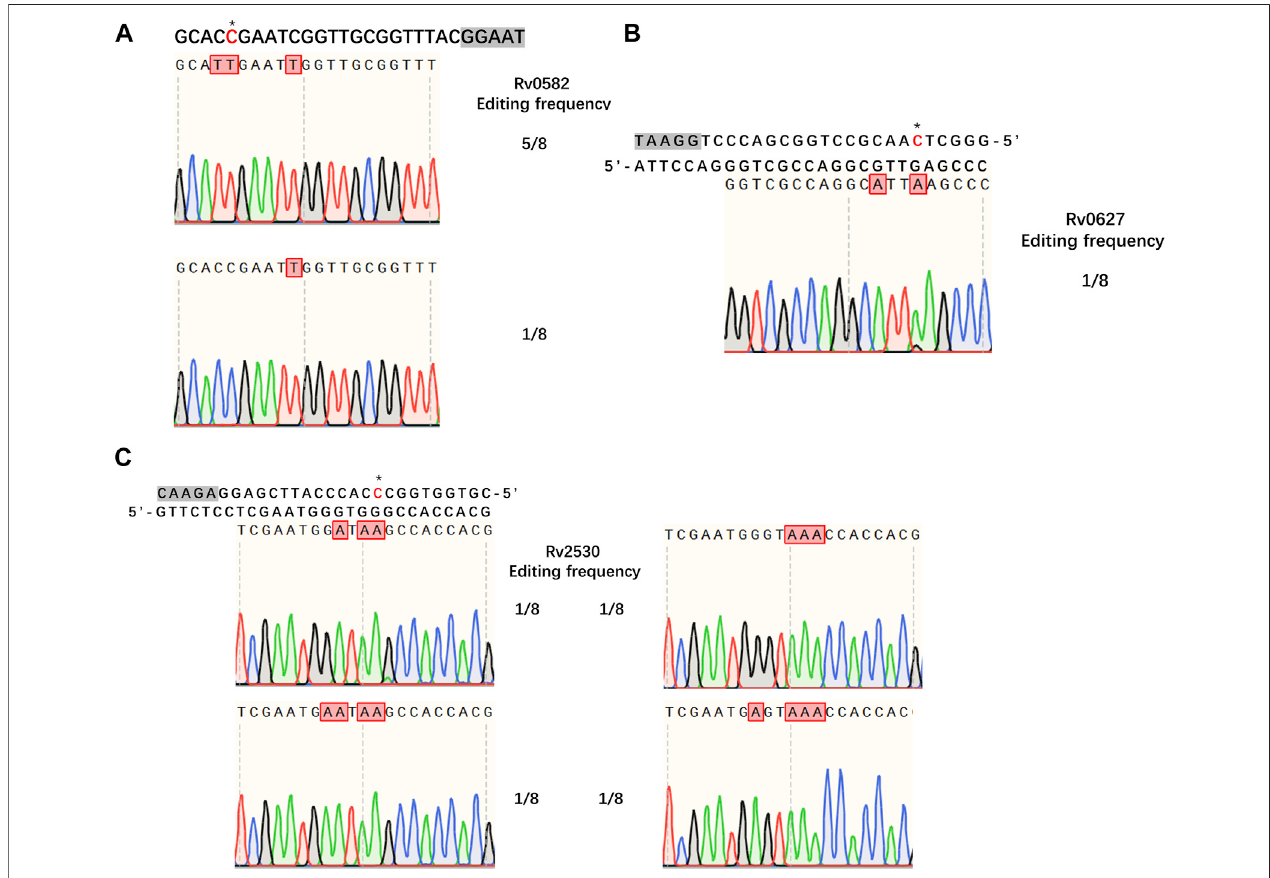
FIGURE 4 | Cytidine base editing in Mtb. (A – C) Sequence alignments of the targeted loci from eight randomly picked colonies: (A) Rv0582 , (B) Rv0627 , (C) Rv2530 . A grey box indicates the PAM sequence. Desired cytidines are marked with an asterisk and edited cytidines are shown in red.